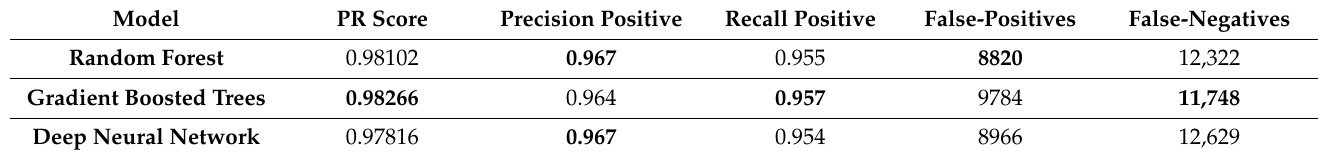
Table 4. Comparison of models based on metrics.